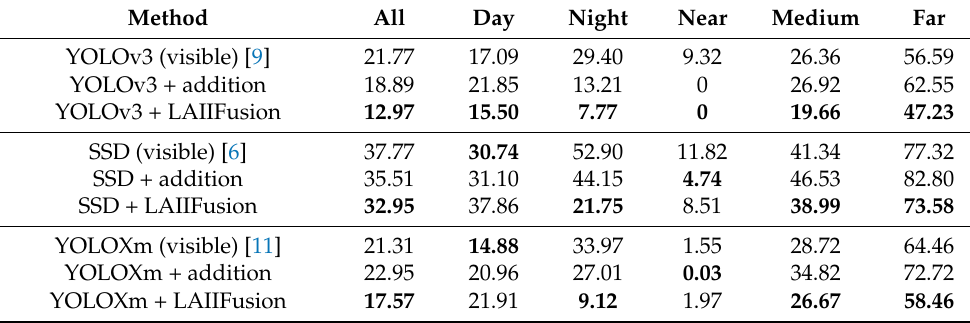
Table 5. Results of visible modality, addition, and LAIIFusion on KAIST dataset.